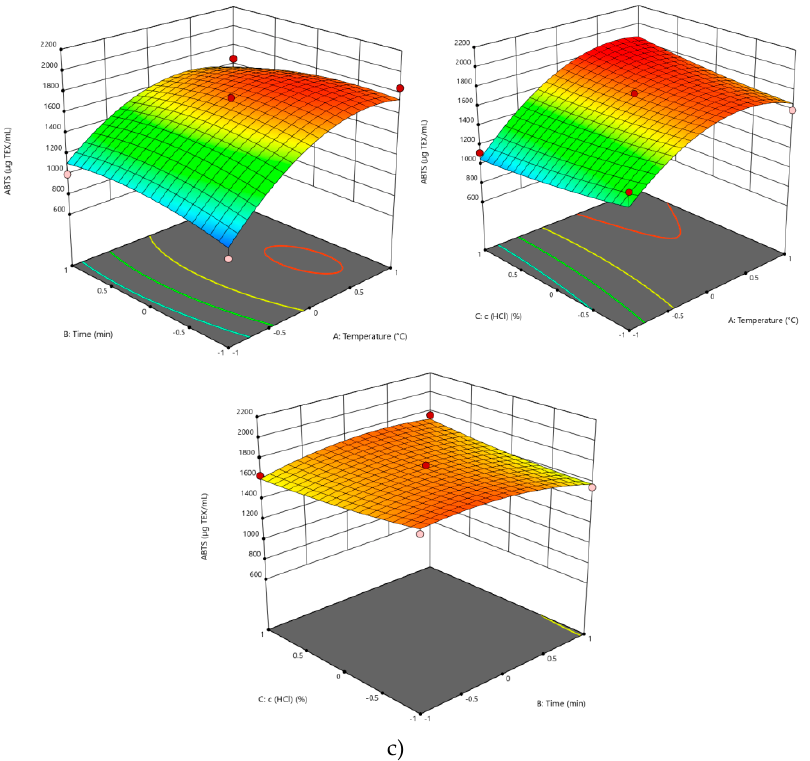
Figure 1. Three-dimensional plot for the obtained responses of ( a ) total phenols (TPH), ( b ) total flavonoids (TFL), and ( c ) antioxidant activity as a function of extraction temperature, time, and HCl concentration.